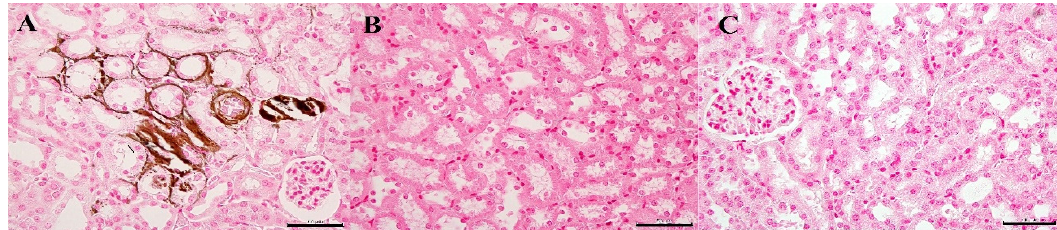
Figure 5. Histopathological changes in the renal tubules. ( A ) Vit D 3 -treated mice. Marked multifocal calcification is observed in the lumens of renal tubules and renal parenchyma. von Kossa stain. Bar = 50 μ m. ( B ) Vit D 3 + SEF-treated mice. Calcification is not found in the renal tissues. von Kossa stain. Bar = 50 μ m. ( C ) Untreated mice. von Kossa stain. Bar = 50 μ m.